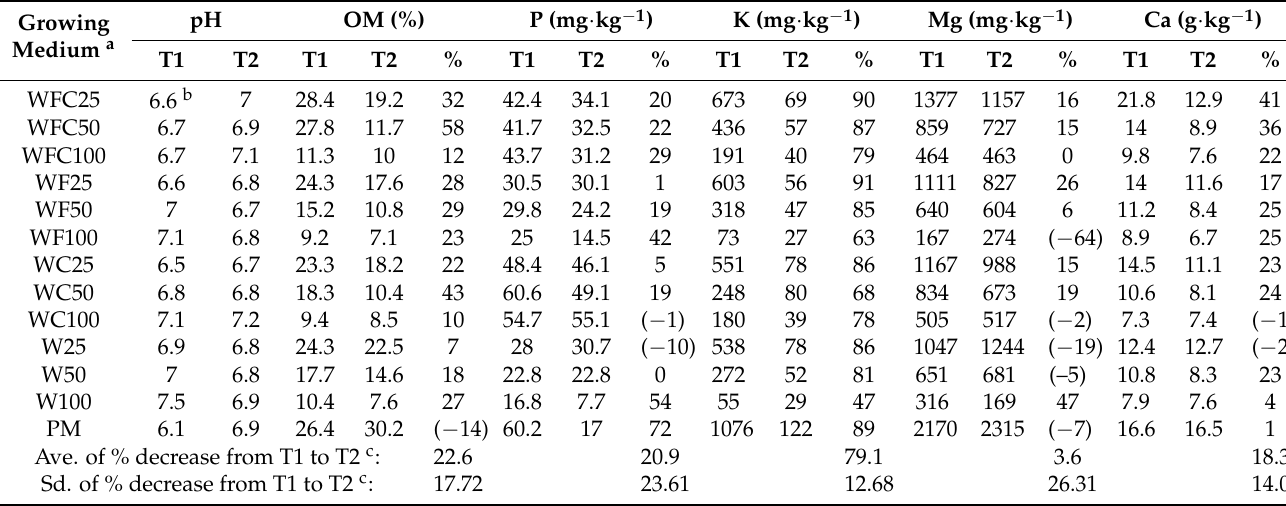
Table 3. Chemical characteristics of growing medium for lettuce production prior to Trial One (T1) and Trial Two (T2) and decrease (%) from T1 to